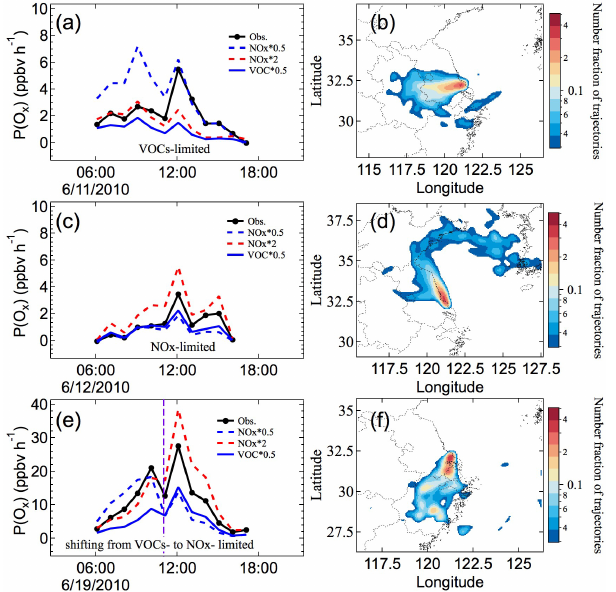
Figure 6. O x production sensitivity of the air masses with different footprint regions. The left panel shows the variation in the produc- tion rate of O x by artificial alteration of NO x and VOCs; the right panel shows the number of trajectories that passed through the mix- ing layer for each case.